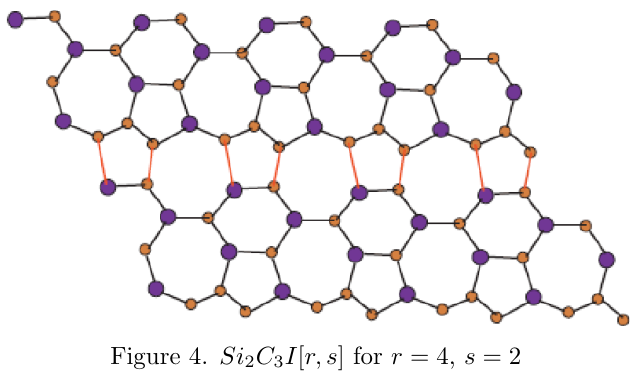
Figure 4. Si 2 C 3 I [ r, s ] for r = 4, s = 2